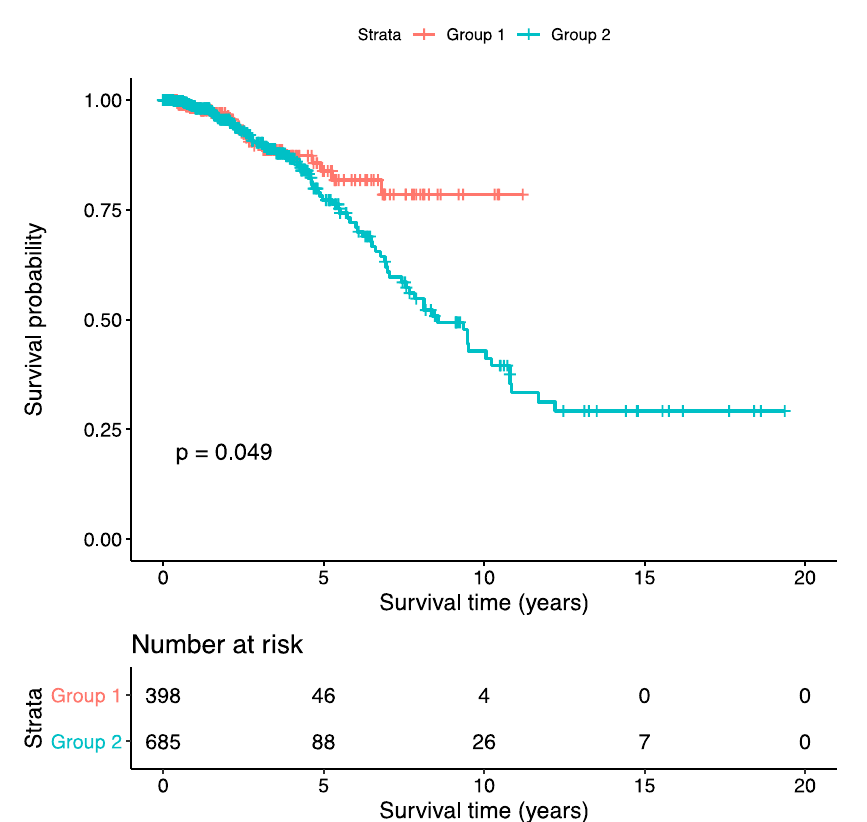
Figure 5. The Kaplan–Meier (KM) plot of the two patient groups clustered by the concatenated features.